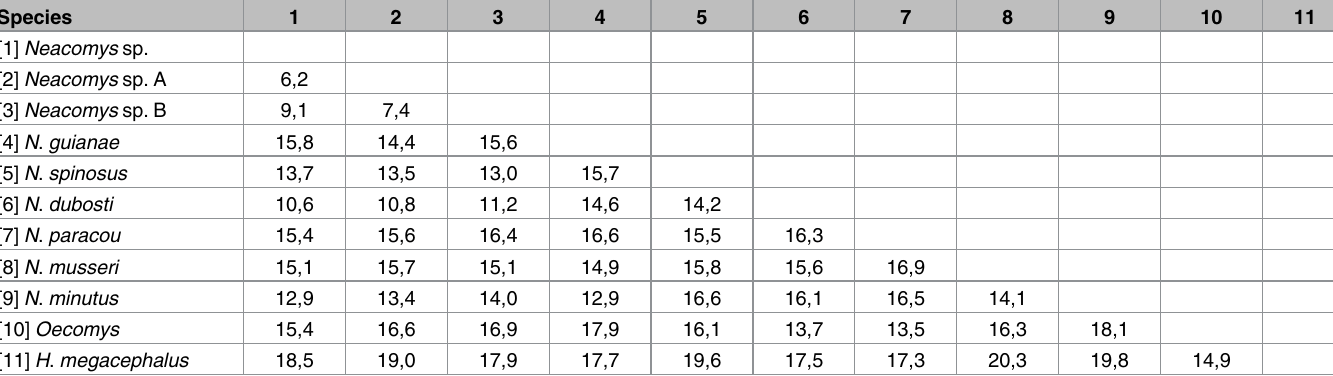
Table 3. Mean genetic distances of the concatenated mitochondrial genes Cytochrome C Oxidase—Subunit I (COI) and Cytochrome b (Cytb) according to Kimura-2 parameters among different Neacomys species recovered in the present study. Values are in percentage(%). Species